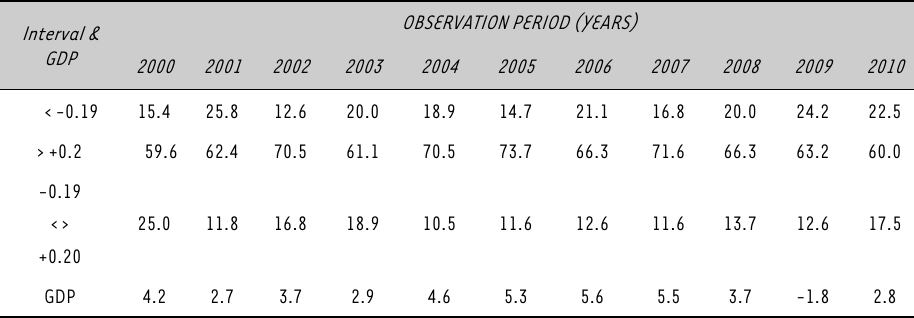
Number of observations less than –0.19, more than +0.2 and between –0.19 and +0.20 as a percentage of the total observations and gross domestic product